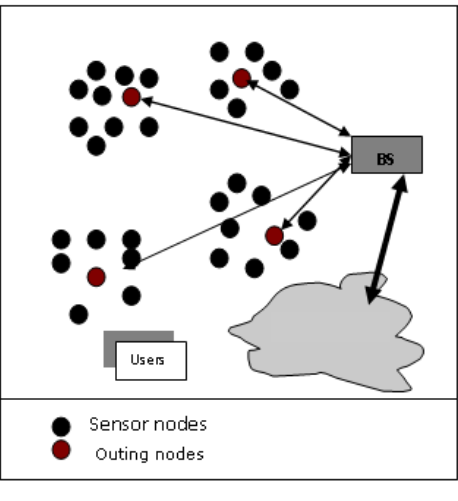
Figure 1. A wireless sensor network